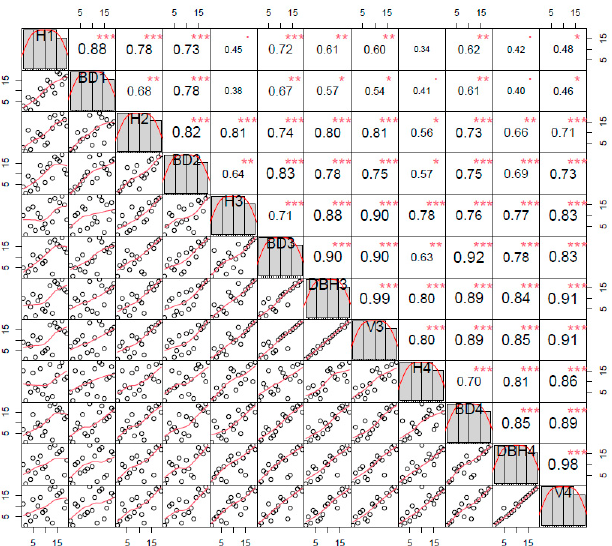
Figure 2. Rank correlation coefficients among different traits. Note: (H1): 1-year-old tree height; (H2): 2-year-old tree height; (H3): 3-year-old tree height; (H4): 4-year-old tree height; (BD1): 1-year-old ground diameter; (BD2): 2-year-old ground diameter; (BD3): 3-year-old ground diameter; (BD4): 4-year-old ground diameter; (DBH3): 3-year-old diameter at breast height; (DBH4): 4-year-old diameter at breast height; ( V 3): 3-year-old volume; ( V 4): 4-year-old volume; *: